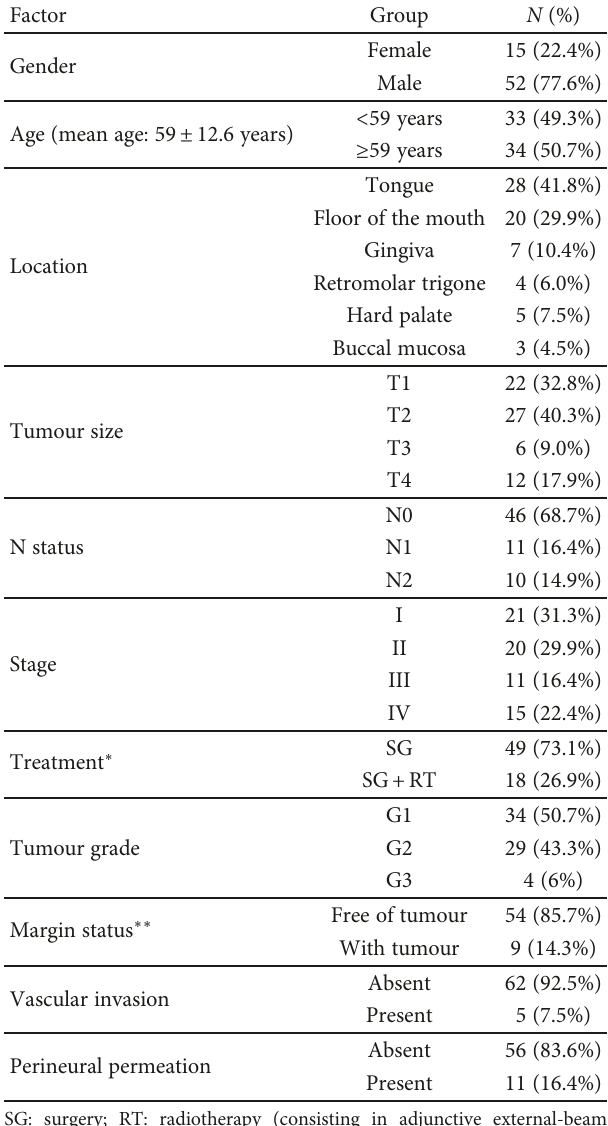
Table 1: Patient characteristics ( N = 67